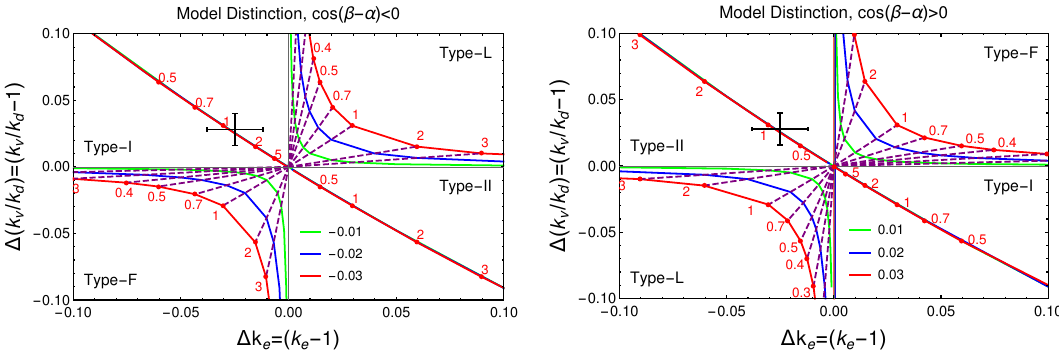
Figure 4 . (cid:1)( (cid:20) V =(cid:20) d ) vs (cid:1) (cid:20) e for four di(cid:11)erent types of 2HDM, varying tan (cid:12) and cos( (cid:12) (cid:0) (cid:11) ). The left panel is for cos( (cid:12) (cid:0) (cid:11) ) < 0 and the right panel is for cos( (cid:12) (cid:0) (cid:11) ) > 0. The green, blue and red lines are for j cos( (cid:12) (cid:0) (cid:11) ) j = 0 : 01 ; 0 : 02 ; 0 : 03 respectively. The dashed lines are for di(cid:11)erent tan (cid:12) values, as labeled in the plot. The black cross indicates the estimated experimental errors with a random central